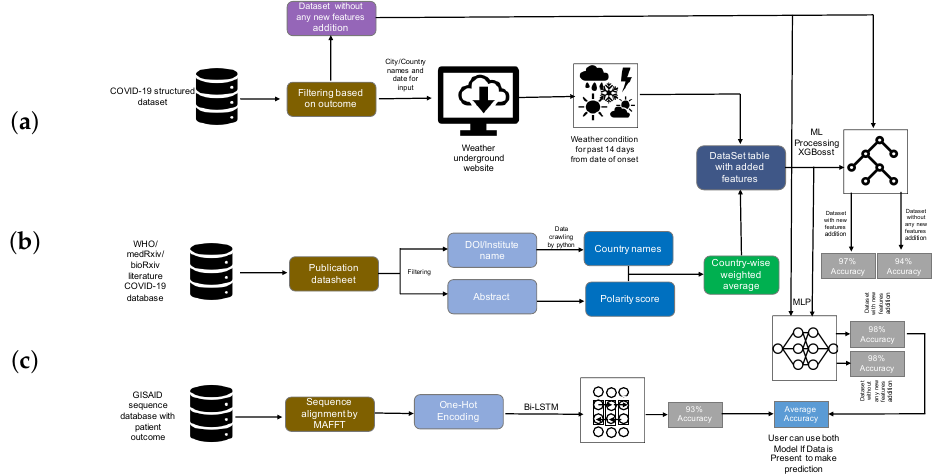
Figure 1. Analysis summary. ( a ) The initial COVID-19 structured dataset was filtered for patients for which the outcome has been recorded, and then, for these items, the weather was determined using the Weather Underground website [38]. ( b ) The WHO, medRxiv, and bioRxiv COVID-19 literature database were filtered and preprocessed to extract author institute/address/country, and these were postprocessed so as to obtain a country-wise research sentiment polarity score. XGBoost and Multi-Layer Perceptron (MLP) were trained on both the initial and the enhanced structured data, and the accuracy of survival prediction was shown to be 94% and 97% (using XGBoost), and 98% and 98% (using MLP), respectively. ( c ) Bidirectional Long Short-Term Memory (Bi-LSTM) was used to train a classification model on the sequence dataset, the accuracy was 93%. Finally, the MLP model and Bi-LSTM models were stacked to jointly predict